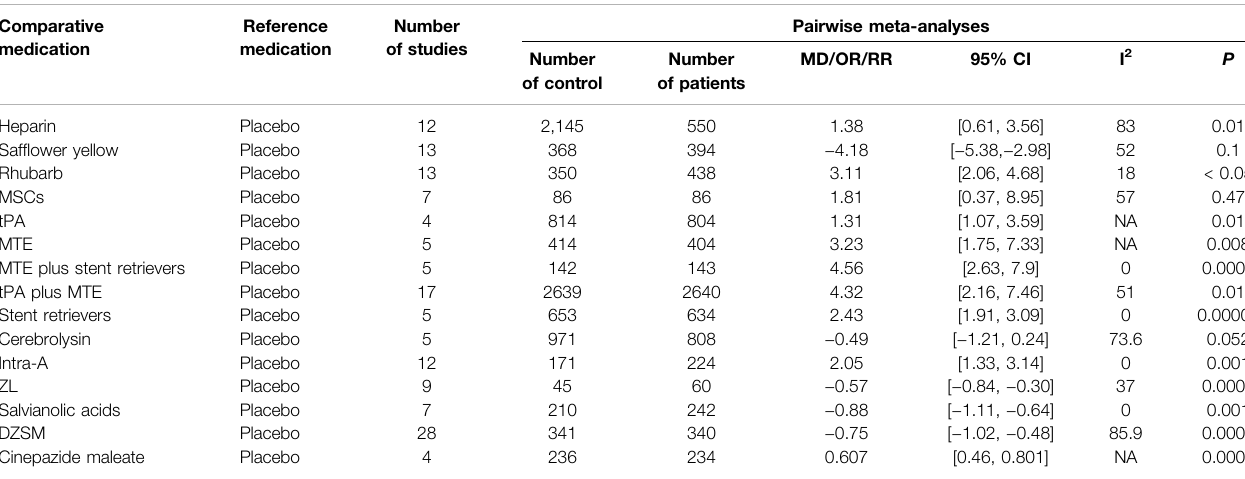
TABLE 4 | Results of pairwise meta-analyses for the mRS score. Comparative